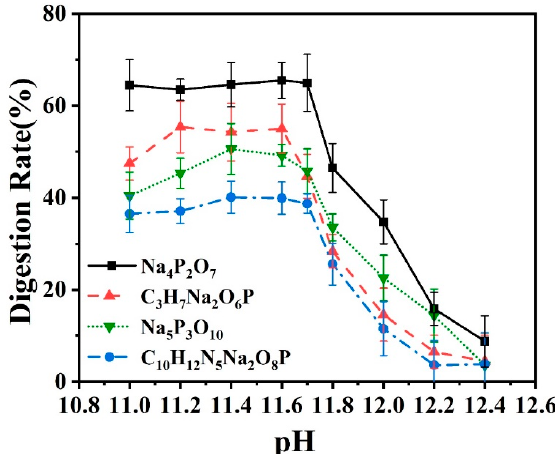
Figure 7. Online measurement of the digestion efficiency of four kinds of phosphate solution samples under different pH values at the digestion temperature of 90 °C and the concentration of K 2 SO 4 was prepared as 50 g/L.